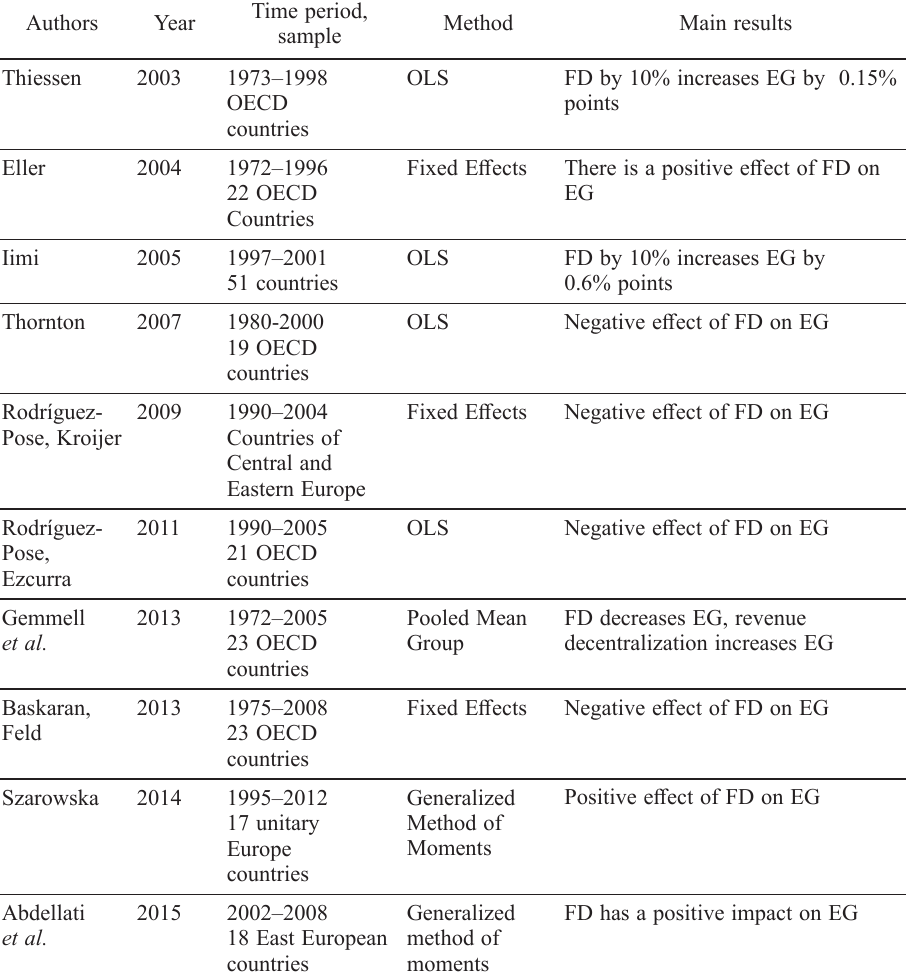
Table 1. Empirical findings in cross-countries